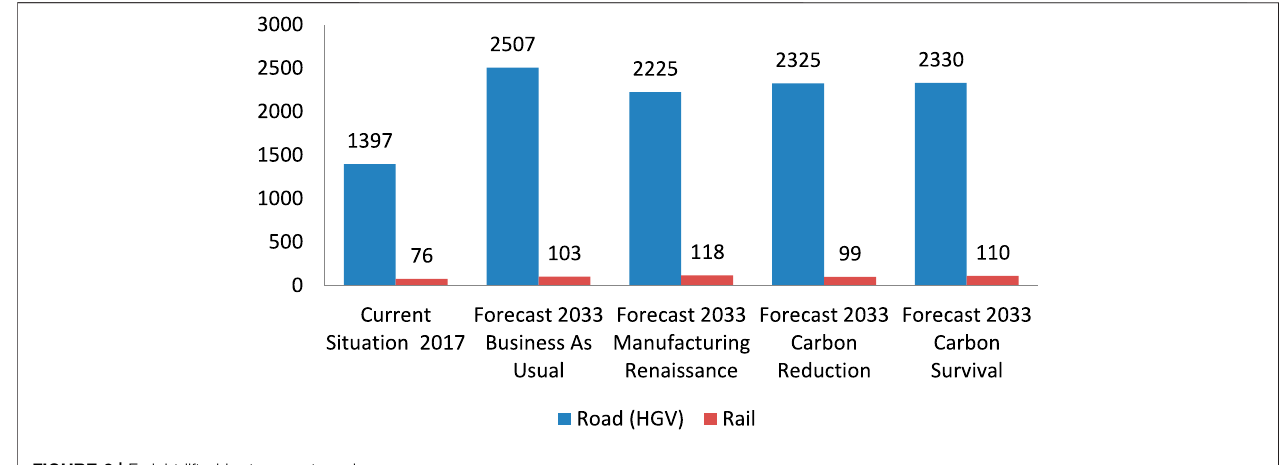
FIGURE 2 | Freight lifted by transport